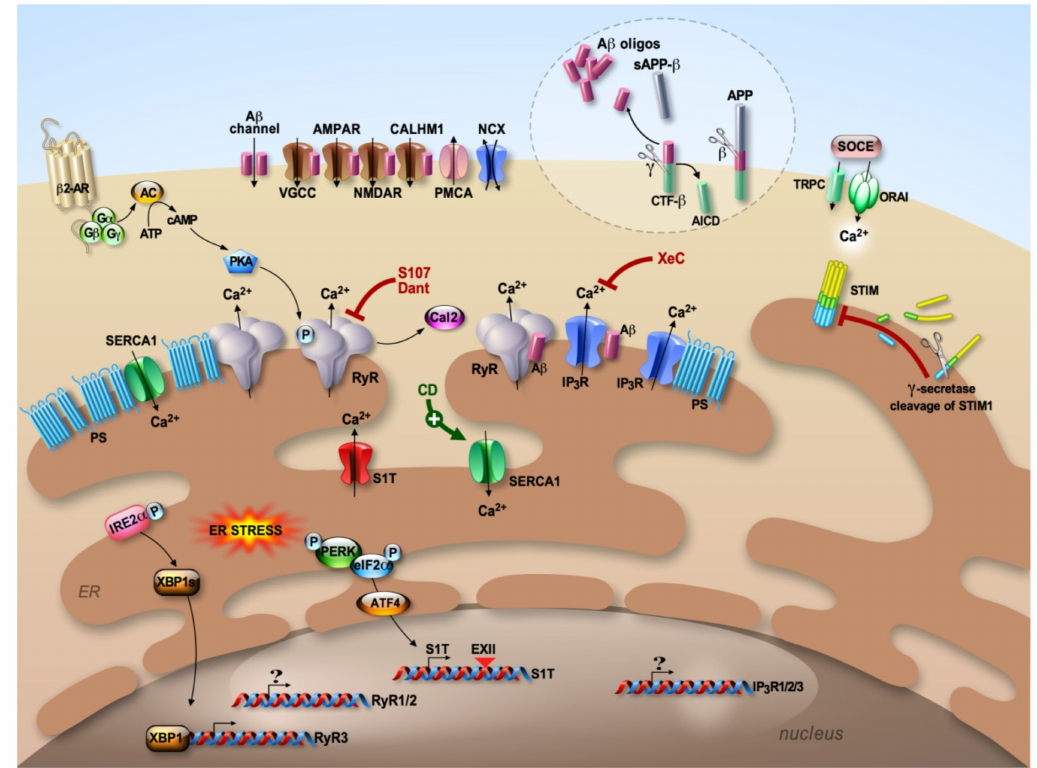
Figure 2. A β peptides are derived from the processing of the β APP (APP) through the amyloidogenic pathway. APP is first cleaved by β –secretase ( β ), generating APP C-terminal fragment β (CTF- β ), which is then cleaved by γ –secretase complex ( γ ) to produce A β and APP intracellular domain (AICD). At the plasma membrane, A β form a cation channel and modulate several Ca 2 + channels (VGCC, AMPAR, NMDAR and CALHM1). ER Ca 2 + deregulation occurs through presenilin (PS)-associated Ca 2 + leak and / or enhanced IP 3 R- and RyR-mediated Ca 2 + release, dysfunctional Sarco-endoplasmic reticulum Ca 2 + ATPase (SERCA) activity, enhanced expression of S1T driven by ER stress response and enhanced expression and dysfunctional IP 3 Rs and RyRs. SOCE is also deregulated in AD and implicates STIM, ORAI and TRPC. RyR2 macromolecular complex destabilization (PKA phosphorylation and calstabin2 (Cal2) dissociation) is linked to β 2-adrenergic receptor activation. Pharmacological stabilization of ER Ca 2 + content by S107, Dantrolene (Dant) blocking RyRs-mediated Ca 2 + release / leak, Xestospongin C (XeC) blocking IP 3 R-mediated Ca 2 + release and CD1163 (CD) activating SERCA provided